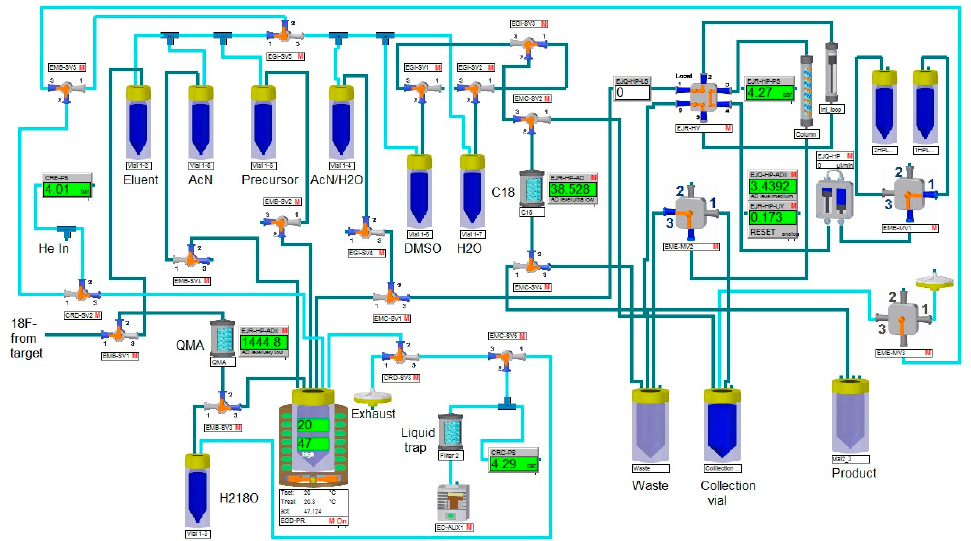
Figure 7. The synthesis scheme of 4-[ 18 F]fluorobenzylazide.